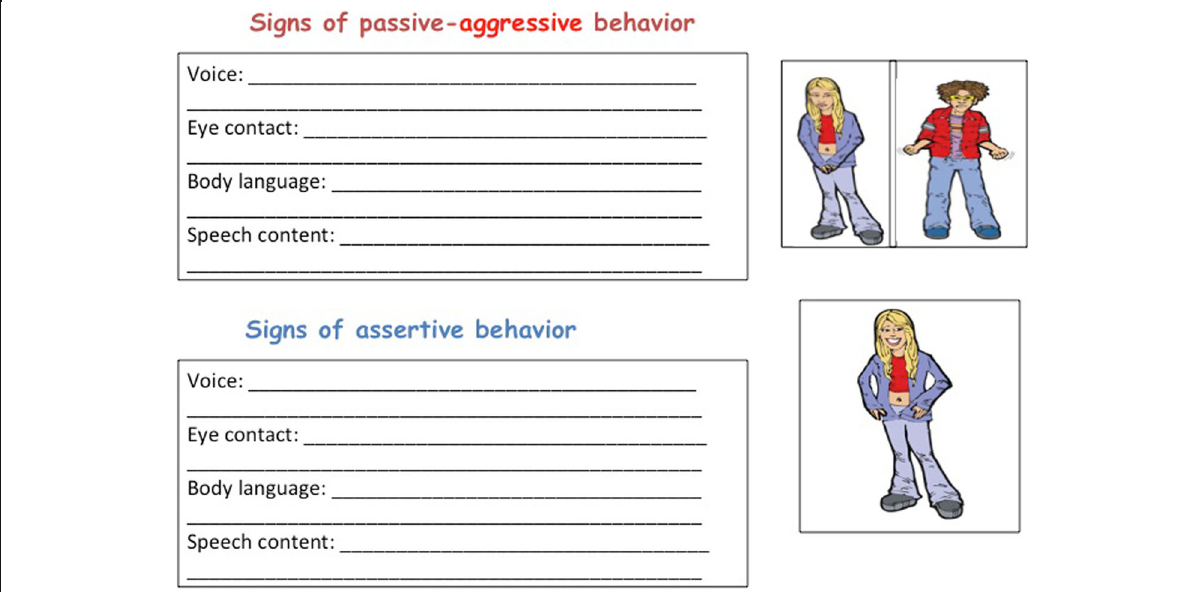
Fig. 9 Worksheet to collect signs of passive-aggressive and assertive